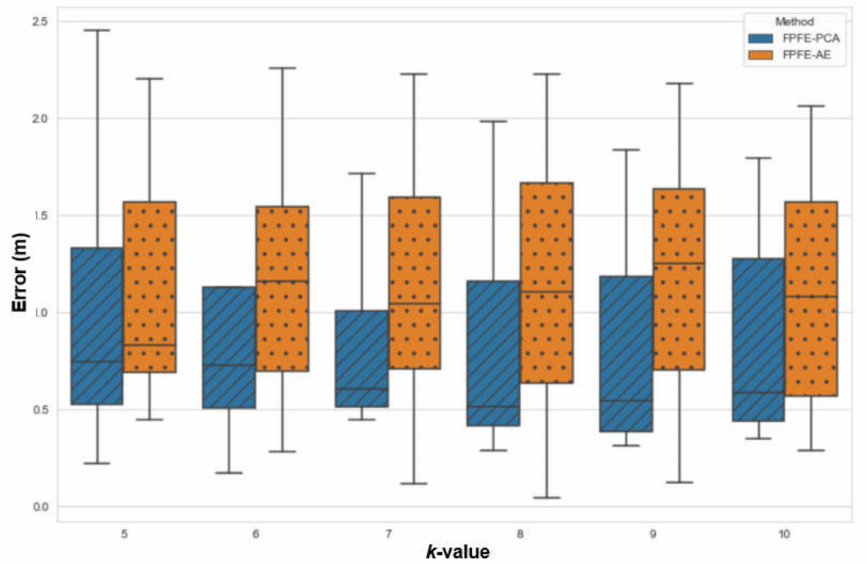
Figure 13. The localization error box and whisker plots of FPFE with 93 random RPs for k RP candidates, where k = 5, 6, 7, 8, 9, and